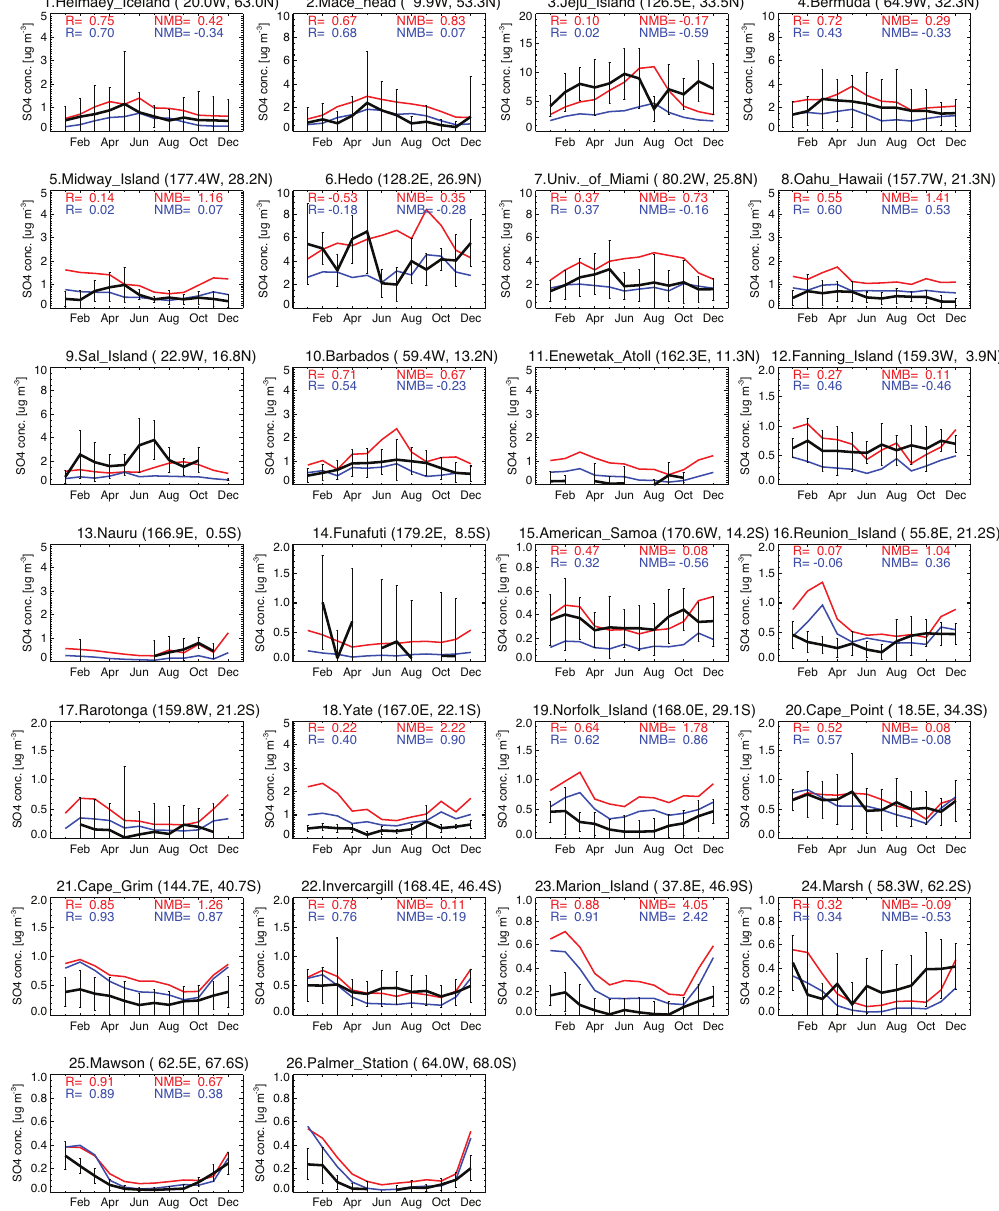
Figure 9. Comparisons of monthly averaged surface sulfate mass concentrations (µgm − 3 ) simulated (red for ModelE2-TOMAS and blue for ModelE2-OMA) and measured (black solid line with an error bar showing a standard deviation) by the University of Miami. Correlation ( R ) and normalized mean bias (NMB) are provided only when the observation is available for 12